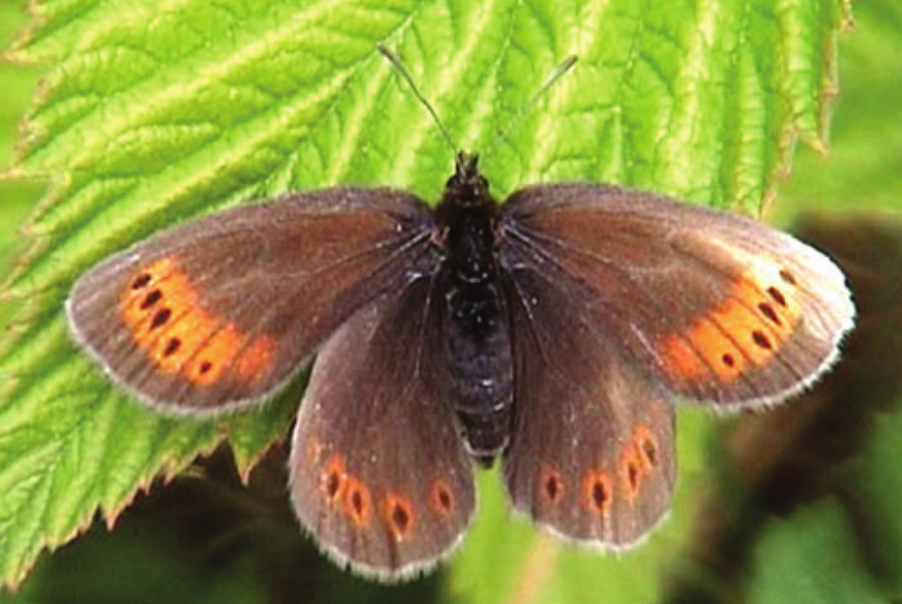
Erebia christi . Photo Matt Rowlings.